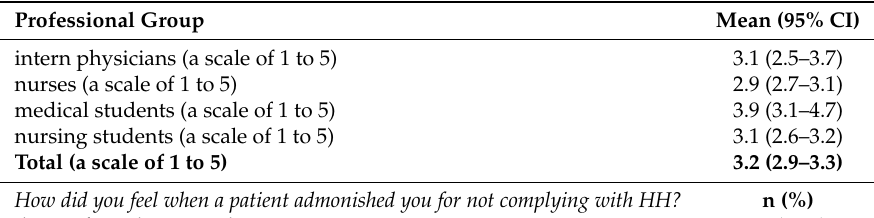
Table 6. Subjective rating on a scale of 1 to 5 of the observed level of hand hygiene of other HCWs and HCW attitudes towards problems associated with compliance with the rules of hand